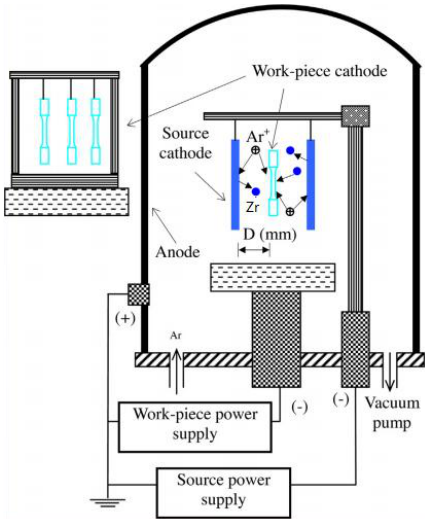
Figure 2. Schematic diagram of glow plasma metallurgy equipment.